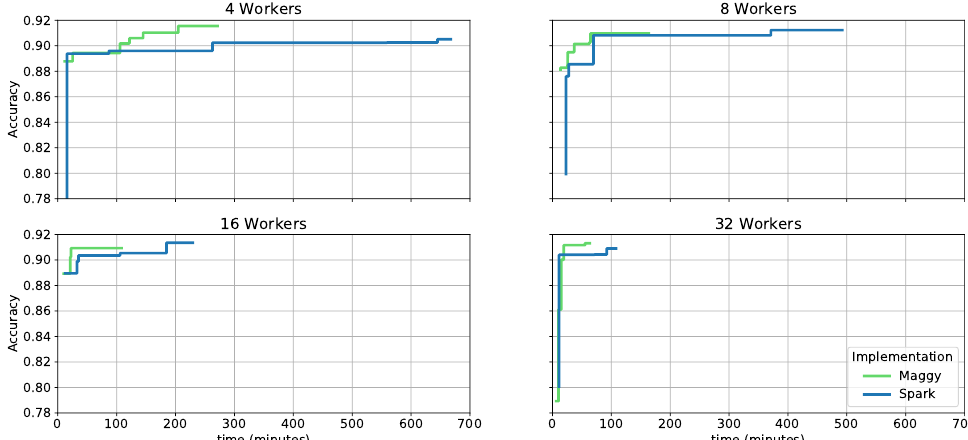
Figure 14. M AGGY finds better configurations faster through the asynchronous parallel execution and early stopping of under-performing trials. Due to shorter trials, M AGGY concludes experiments with the same number of trials in a shorter wall-clock time. Each trial in Spark, the Experiment API, is run to completion with no early stopping, producing a similar accuracy as expected and resulting in a higher wall-clock time needed to execute 100 trials than M AGGY [4].